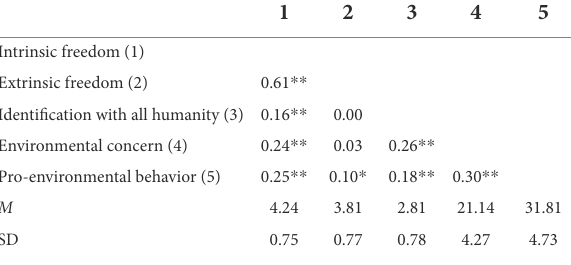
TABLE 1 Intercorrelations and descriptive